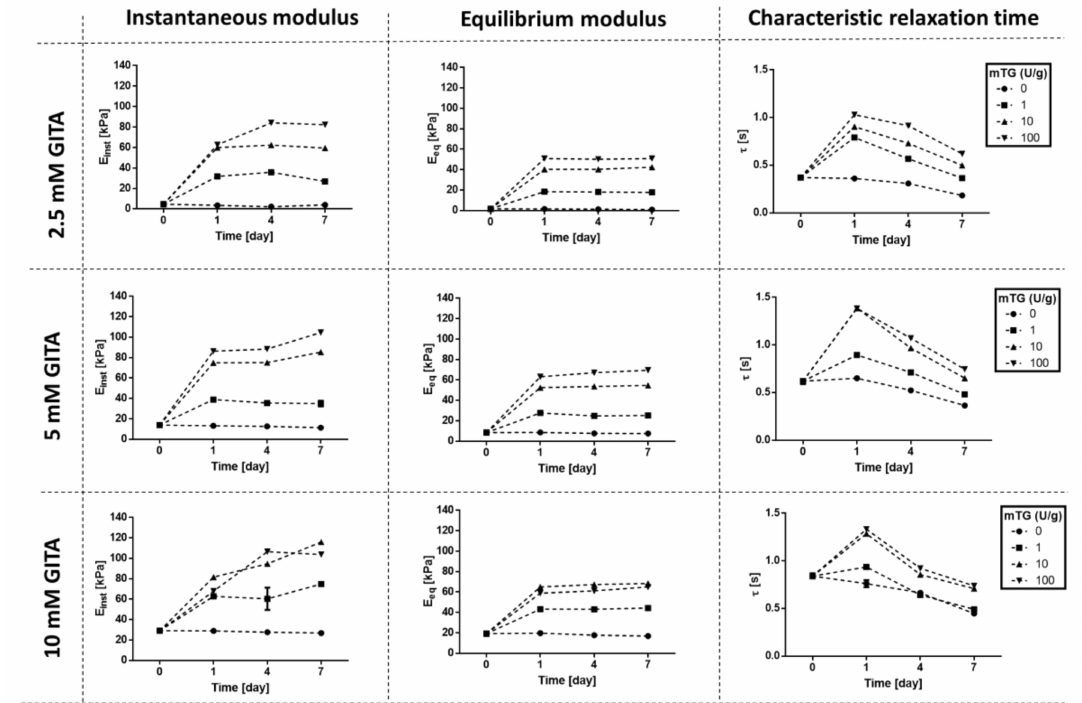
Figure 3. Instantaneous ( E inst ) and equilibrium ( E eq ) elastic moduli and characteristic relaxation times of GTA-crosslinked gelatin hydrogels incubated with mTG for 1, 4, and 7 days. Error bars are scarcely visible due to their very low values (SEM values are reported in the Supplementary